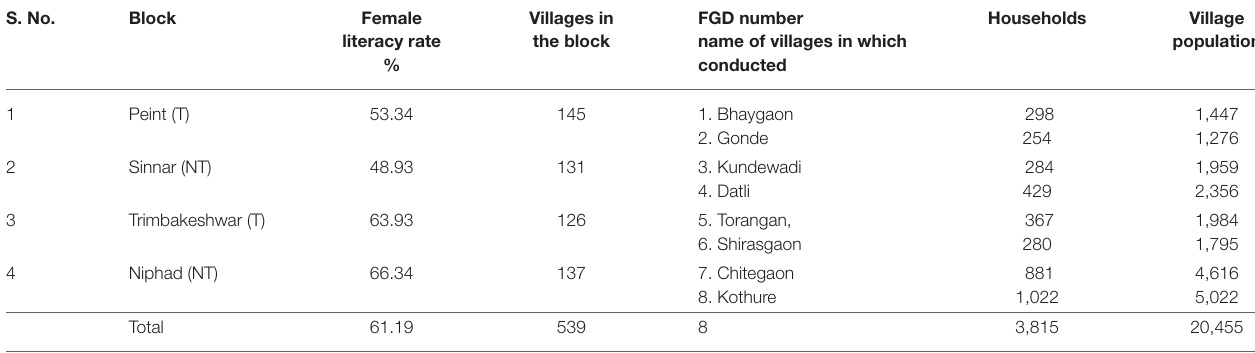
FGD, Focus group discussion; T, Tribal; NT, Nontribal.